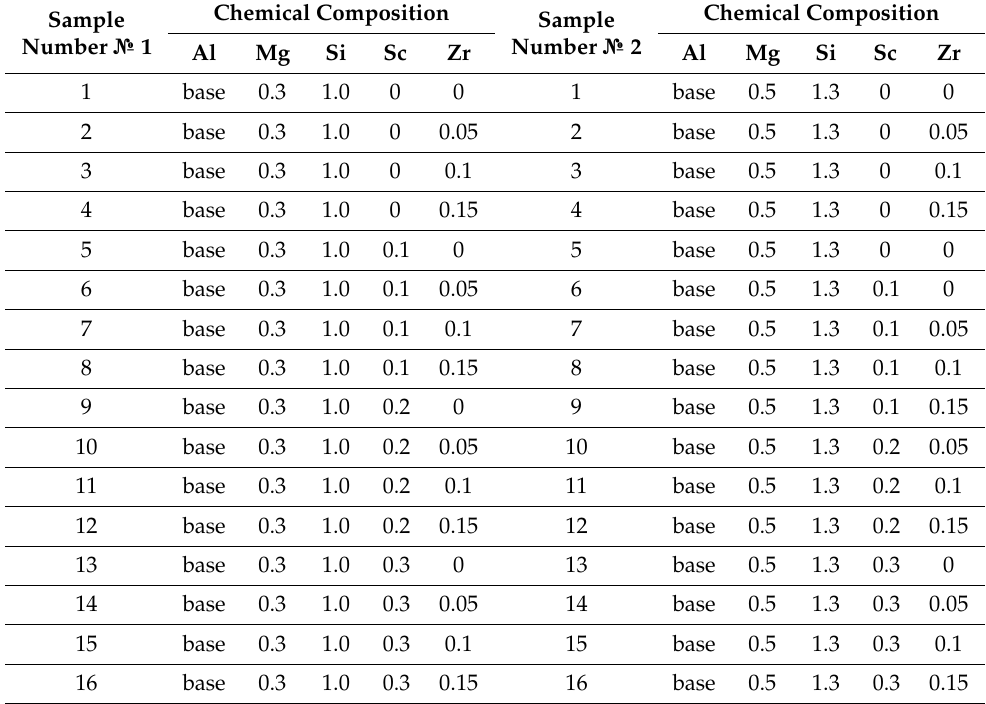
Table 1. Chemical composition of the investigated